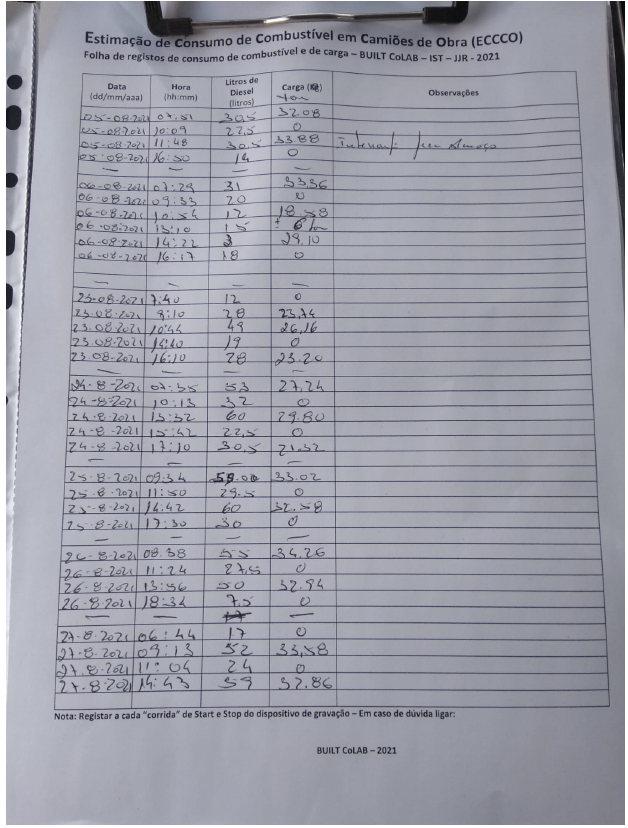
Figure 4. One of the form